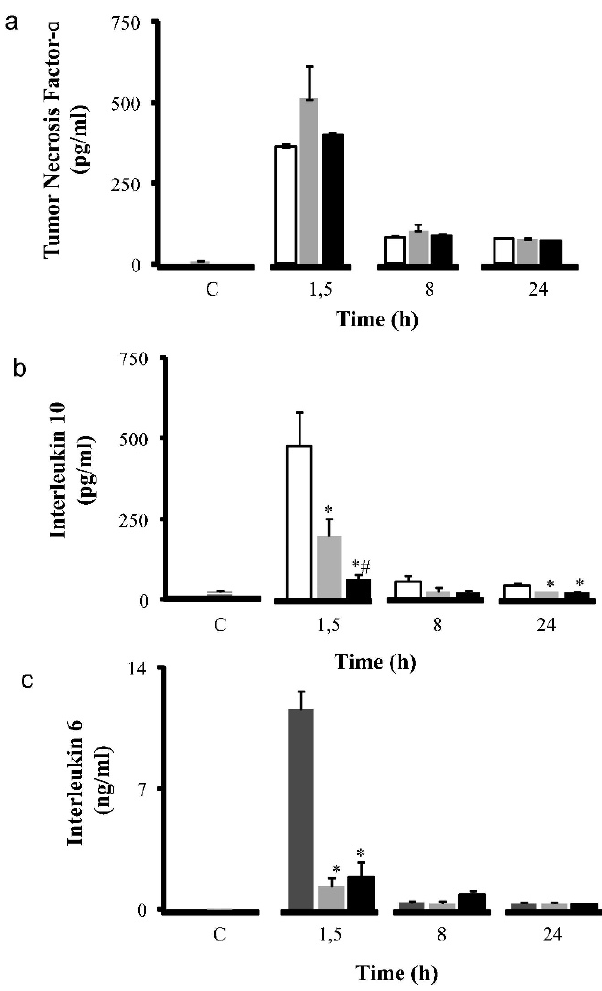
Figure 1 - Inflammatory profile - Cytokine concentrations (pg/ml) in serum: TNF- a (a), IL-10 (b), and IL-6 (c). Wistar male rats were challenged with LPS (LPS - white) and treated with SH (LPS + H - black) and SS (LPS + S - gray). The levels of TNF- a , IL-10 and IL-6 were measured at 1.5, 8 and 24 h after the administration of LPS in serum. * p , 0.05 when compared to the LPS group in the same period. # p , 0.05 when compared to the LPS + S group in the same period. Data are means ¡ SEM.